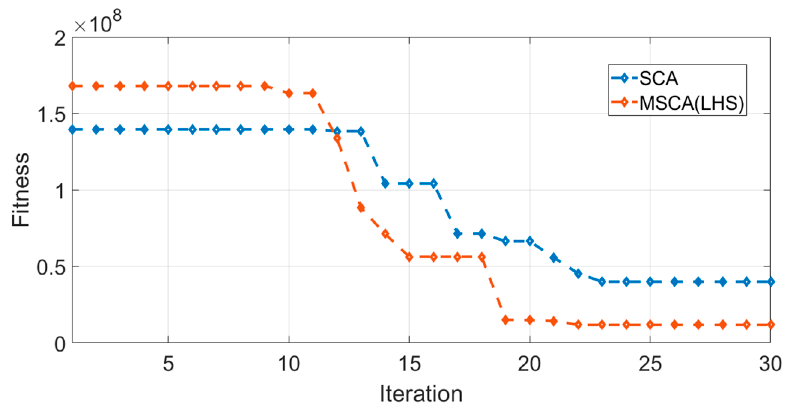
Figure 3. Convergence curves of SCA and modified Sine Cosine Algorithm (MSCA). Algorithm 1. Pseudo-code of MSCA Algorithm